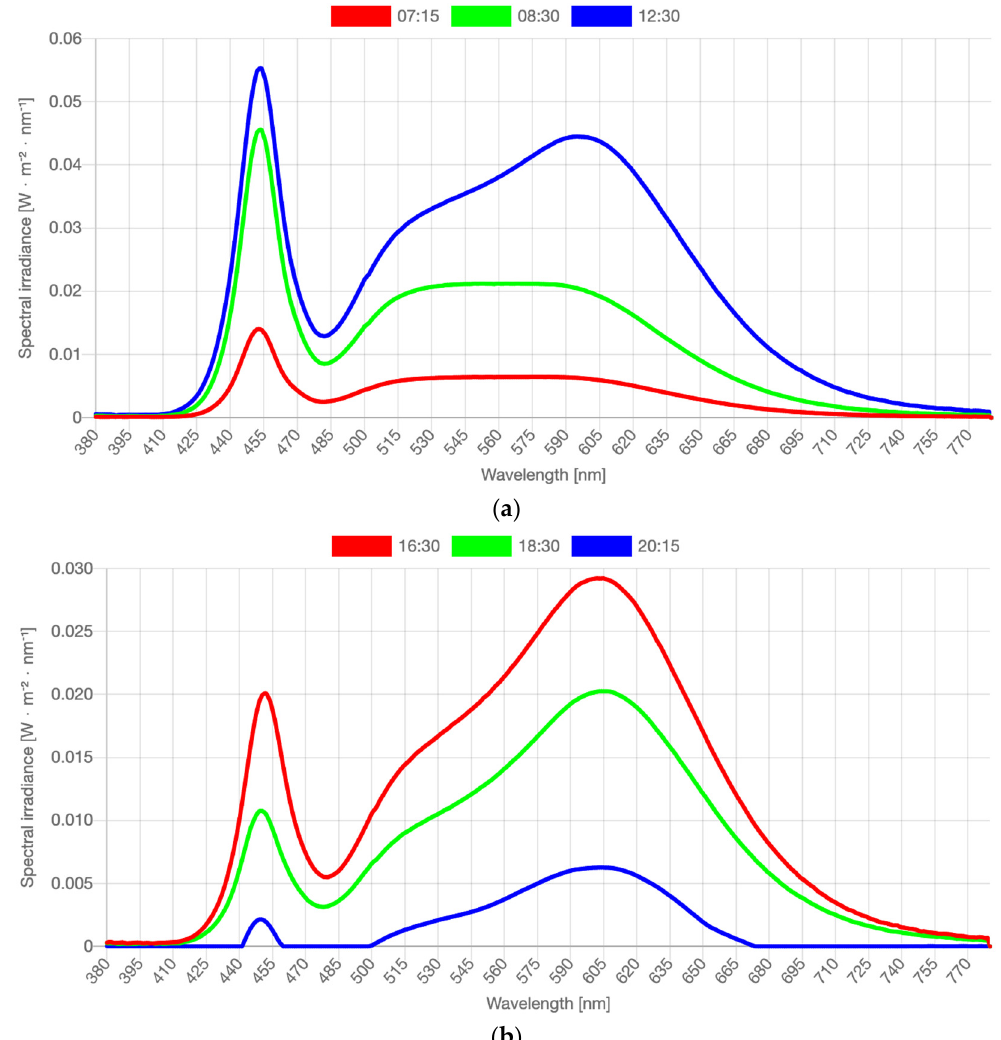
Figure 2. ( a ) Spectral distributions measured in the middle of dynamic phases as reported in Table 2: measured at 07:15 a.m., 08:30 a.m., and 12:30 p.m. ( b ) Spectral distributions measured in the middle of dynamic phases as reported in Table 2: measured at 16:30 p.m., 18:30 p.m., and 20:15 p.m. Note: Full stimulus specification tables and spectra are publicly available via the OSF [41]. Graphs and stimulus specifications were generated with the Luox platform [42], companion paper [43].